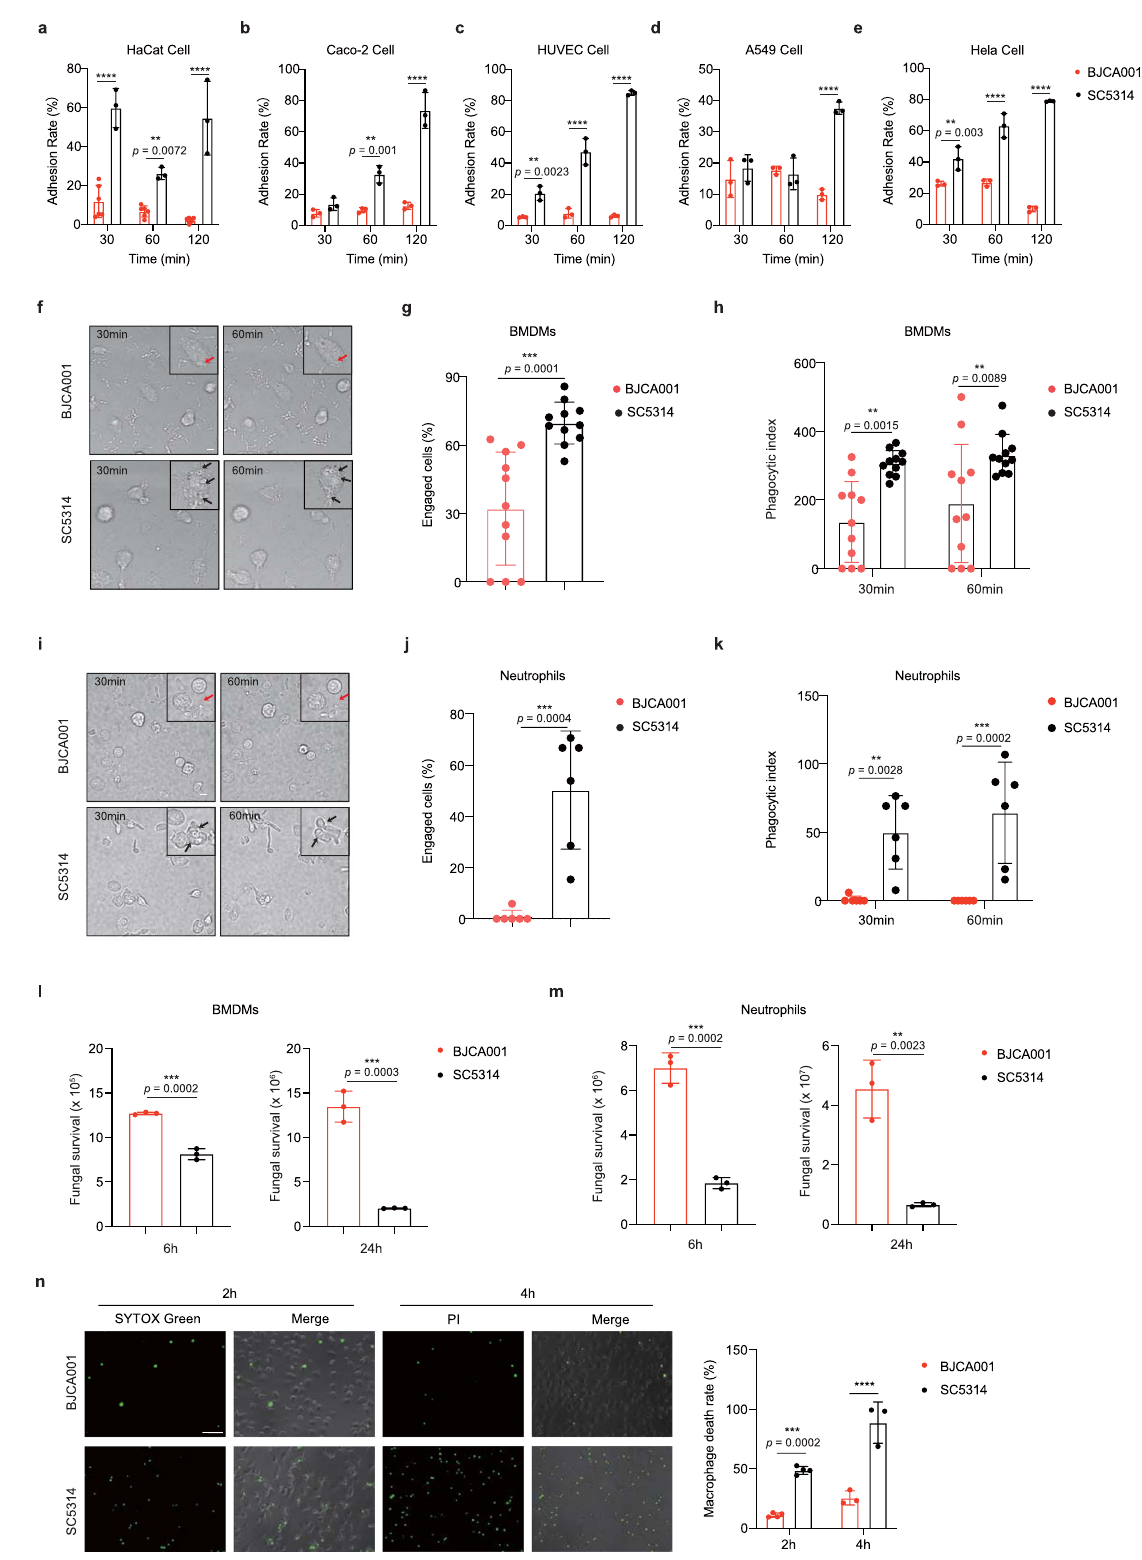
conditions. Moreover, we found that unlike C. albicans , C. auris failed to be endocytosed by Caco-2 cells (Supplementary Fig. 5f, g, Supplementary Movies 1, 2) and some other epithelial or endothelial cells (Supplementary Movies 3 – 10). Second, we investigated host-pathogen interactions by examining the abilities of different immune cells, including macrophages and